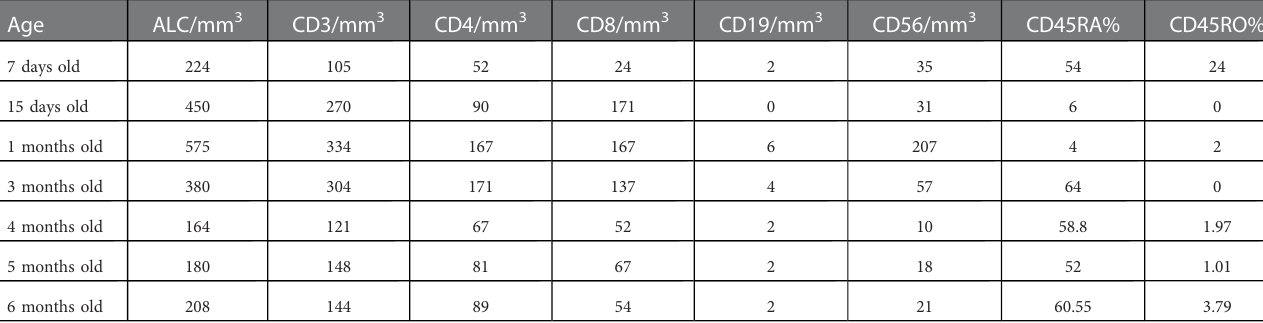
TABLE 2 Patient ’ s lymphocyte immunophenotyping given in absolute counts. Trend over time.